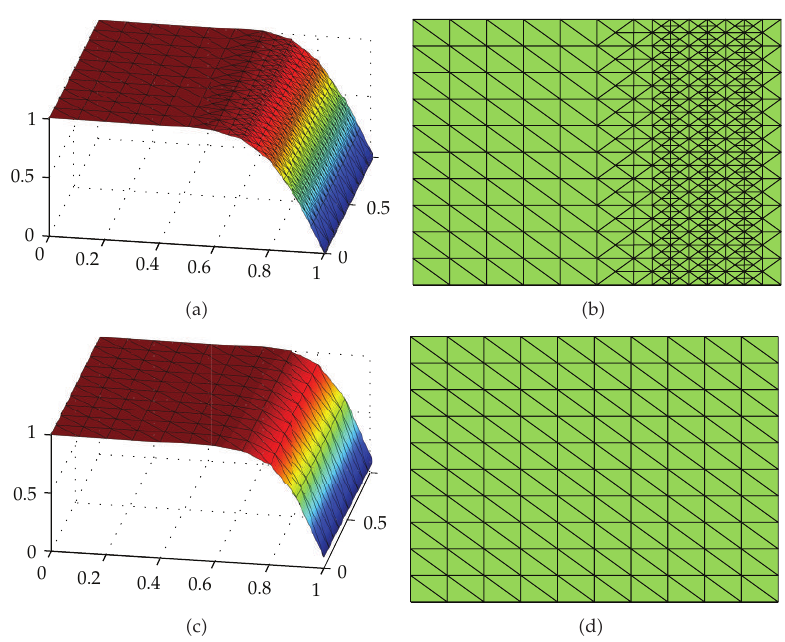
(cid:7) 2 × 10 − 2 . Figures (cid:8) a (cid:9) and (cid:8) b (cid:9) : plots of (cid:4) ρ n o o and T n o . 2 ,h 2 h 2